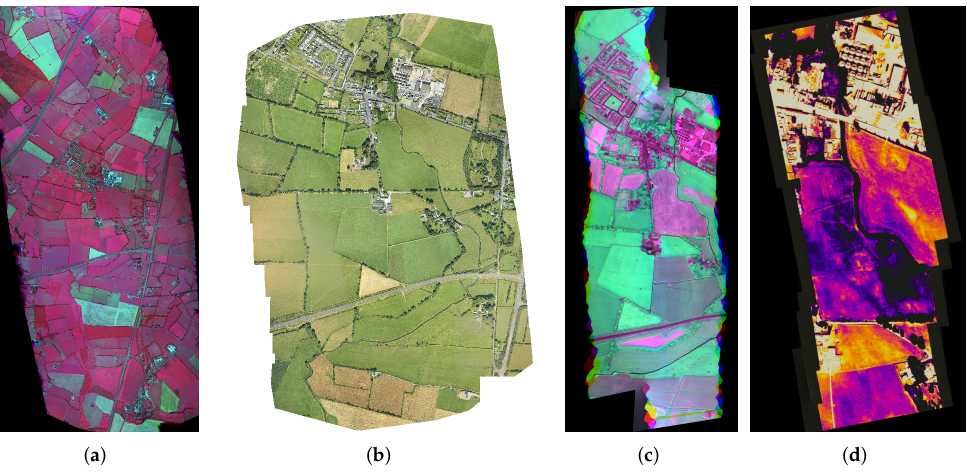
Figure 8. Final outputs from each sensor—image dimensions vary as different FOVs result in different image footprints ( a ) RGB Orthomosaic; ( b ) False Colour Composite from Agrosensor; ( c ) Hyperspectral cube from OCI UAV; ( d ) Thermal image